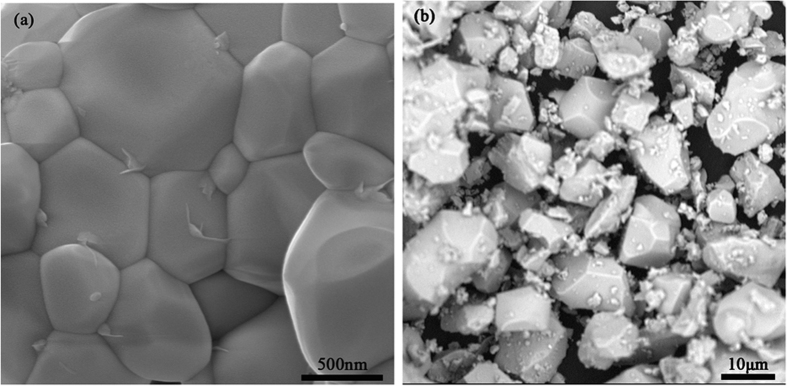
SEM images of Bi4Si3O12: 2 at% Eu3+ phosphors synthesized by (a) microwave and (b) conventional heating.